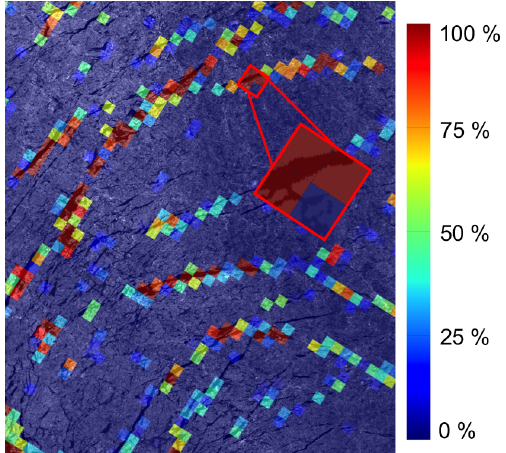
Figure 6. Subset of a SAR image taken on the 8 March 2009 over- laid by the collocated AMSR-E lead fraction (LF) product, where red grid cells correspond to LF 100% (for the other values, see the colour scale on the right). The zoomed-in inset shows four grid cells of which three have AMSR-E LF 100% and one has LF 0%.